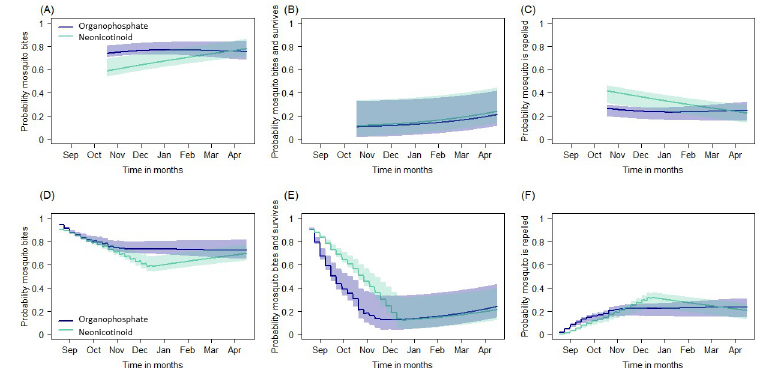
Fig 6. The estimated efficacy of insecticidal sprays wanes with time since delivery. Using the average (and 90% credible intervals) estimated impacts of these sprays [22], we contrast the expected outcomes from mosquito blood- feeding attempts indoors when assuming overnight delivery of the IRS ( A-C )–so that waning begins in October unanimously—to the impacts expected when accounting for the prolonged delivery of the spray campaign ( D-F ). The probability that a mosquito bites, is higher for the organophosphate IRS candidate that was used in Matutuine (blue) than for the neonicotinoid IRS candidate deployed in Boane (green) in both the overnight ( A ) and prolonged ( D ) scenarios, but the probability that the mosquito bites and survives are fairly equivalent ( B & E ) but lower for organophosphate IRS candidate when accounting for the prolonged spray campaigns ( E ). Given the accumulation of protected compounds, the lowest probability of mosquito biting and surviving is achieved in December to January ( B & E ). These effects are reflected in the probability that the mosquito is repelled ( C & F